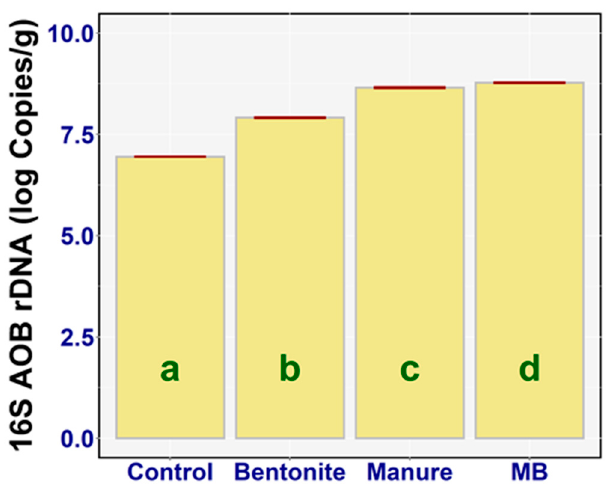
Figure 10. Ammonia-oxidizing bacterial (AOB) rDNA (log Copies / g) of the treatments: means with SEM.